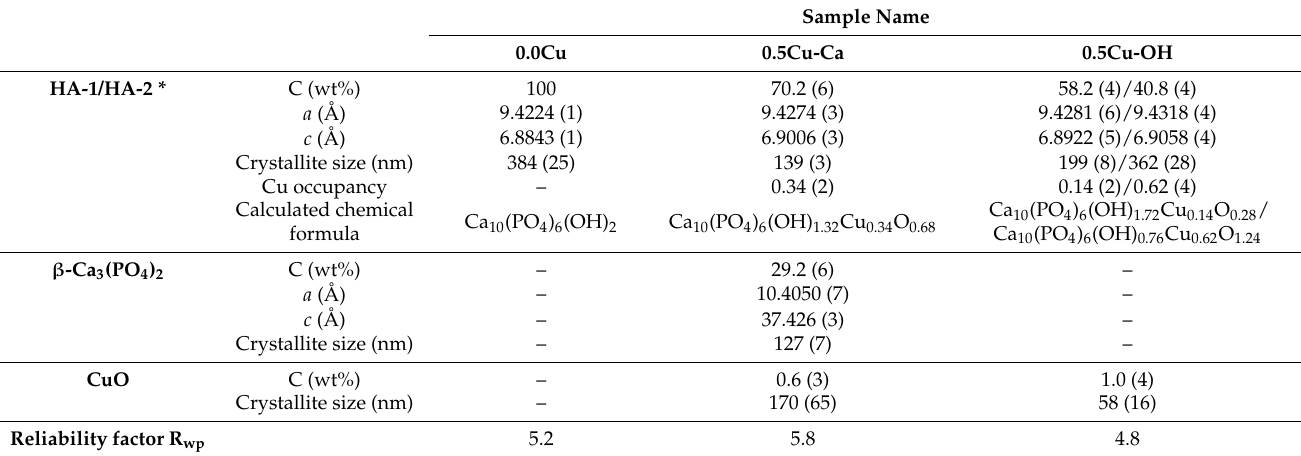
Figure 10. The Rietveld refinement plot for the 0.5Cu-OH sample. Table 4. Concentrations of impurity phases and changes in the coherent scattering region within the cooled samples in the in situ